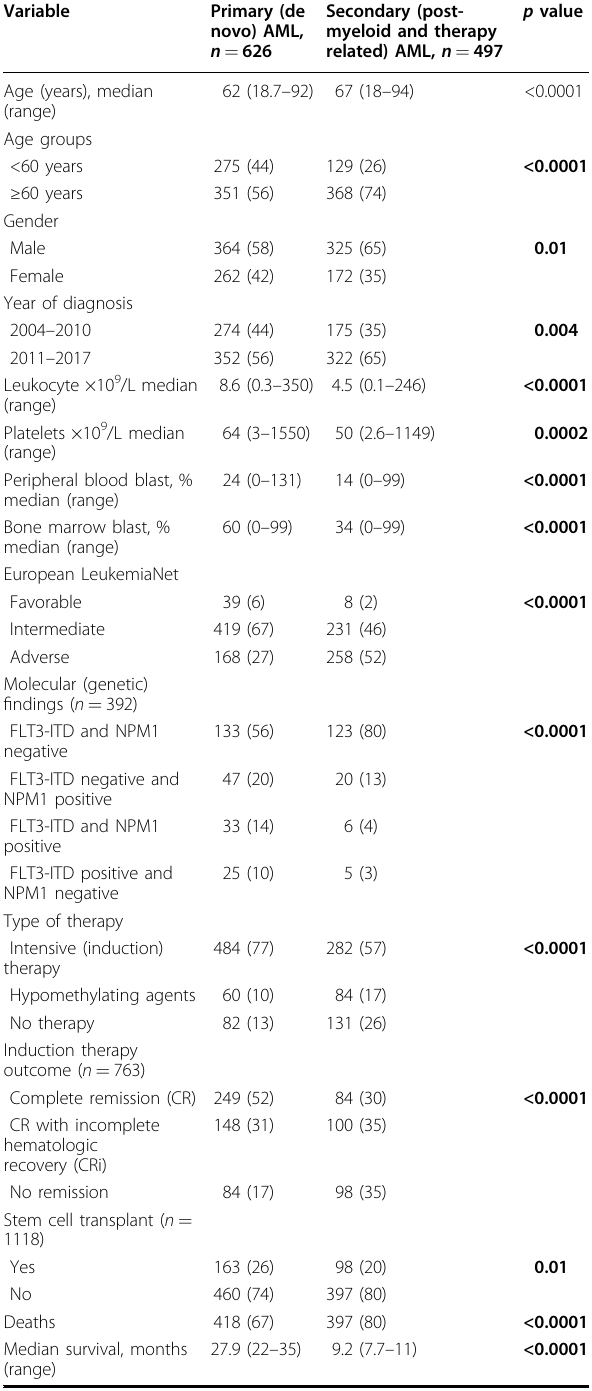
Table 2 Clinical and laboratory characteristics of 626 primary (de novo) and 497 secondary (post-myeloid and therapy related) acute myeloid leukemia (non-APL) patients with complete cytogenetic fi